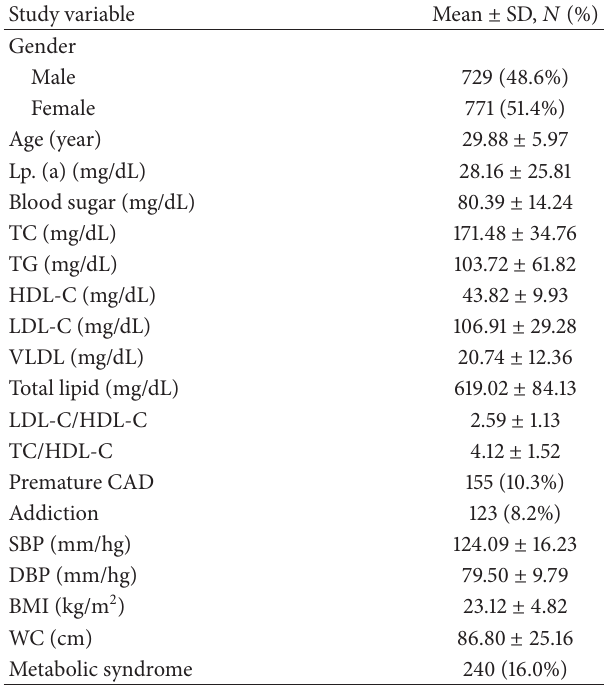
Table 1: Demographic data of the study